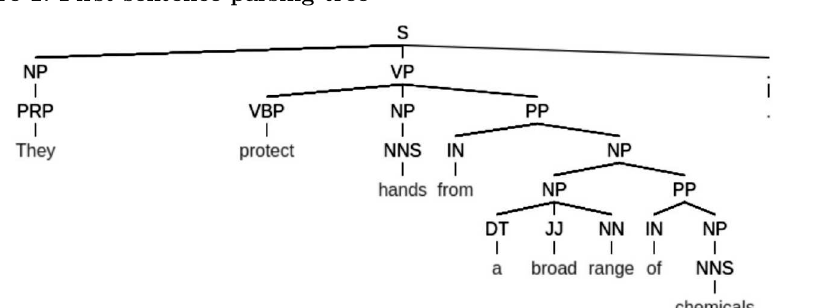
Figure 1. First sentence parsing tree